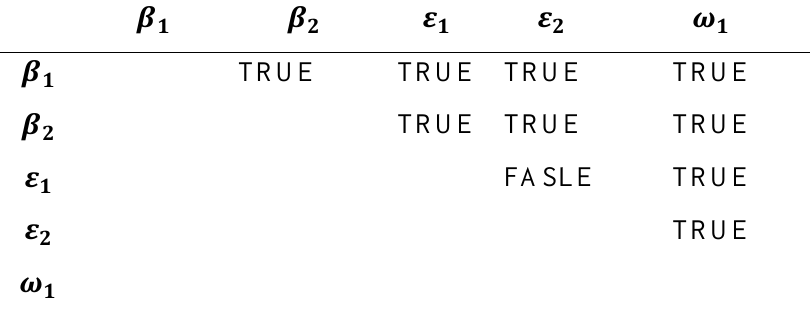
Table 5. Parameters different after FDR